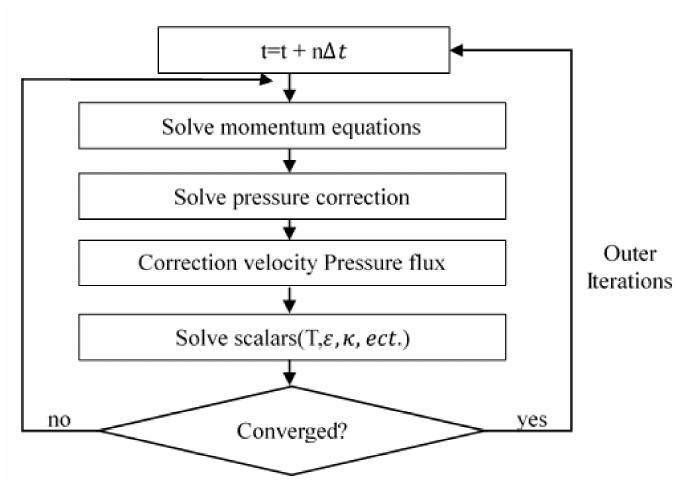
Figure 3. The pressure-implicit with splitting of operators (PISO) pressure–velocity coupling scheme.